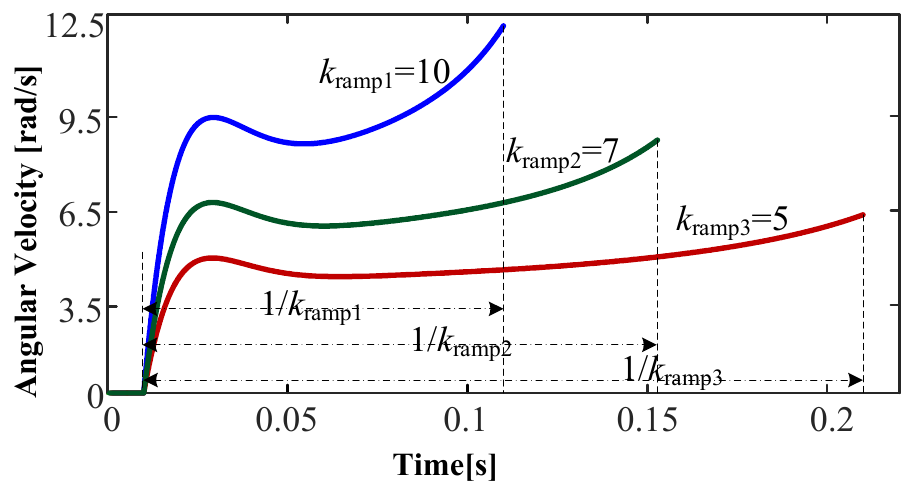
Figure 12. Influence of k ramp on frequency response of internal voltage.